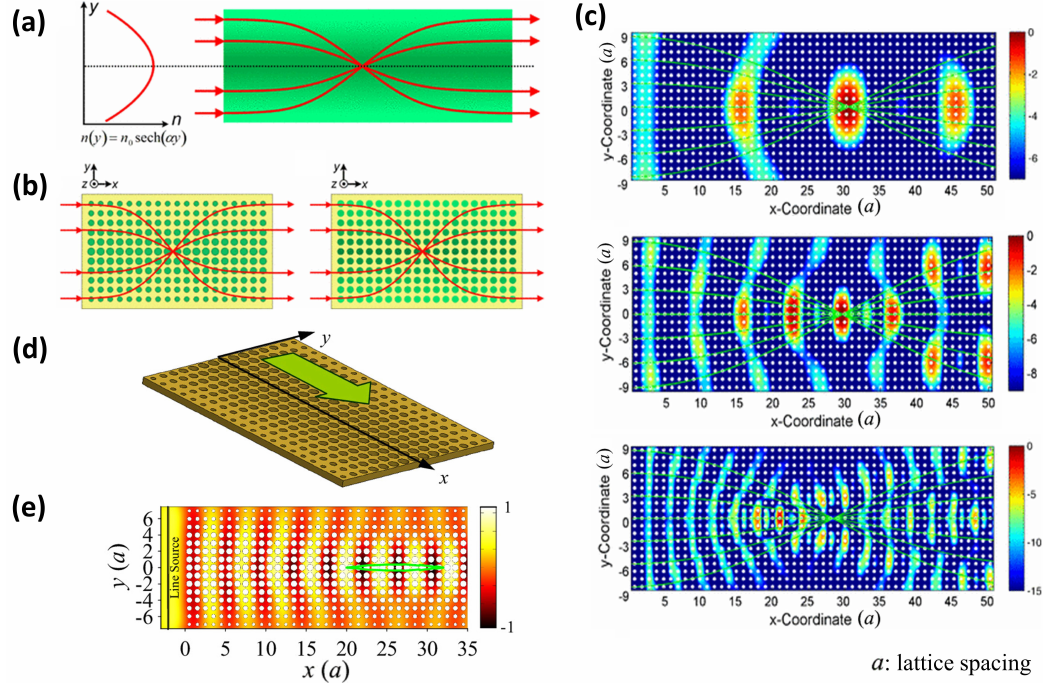
Figure 2. ( a ) Schematic diagram of the principle of a gradient-index (GRIN) lens. Red arrow: incident beams; ( b ) GRIN Phononic crystal (PC) realized by adjusting radius of cylinders (left). GRIN PC realized by changing elastic properties of cylinders (right); ( c ) Finite-Difference Time-Domain (FDTD) simulation of displacement fields when wave propagates in the GRIN PC at a reduced frequency of Ω = 0.05 (top), Ω = 0.10 (center) and Ω = 0.20 (bottom); ( d ) Schematic of the GRIN PC plate. Green arrow: wave propagation direction; ( e ) Displacement amplitude along the x direction measured at 3 MHz. Green contour: area where amplitude > 0.95 times maximum value. ( a – c ) adapted from [72]. ( d , e ) adapted from